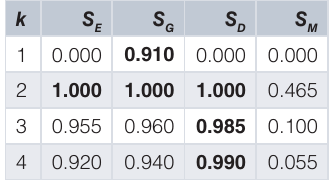
Table 2. Success rate over n = 200 runs.